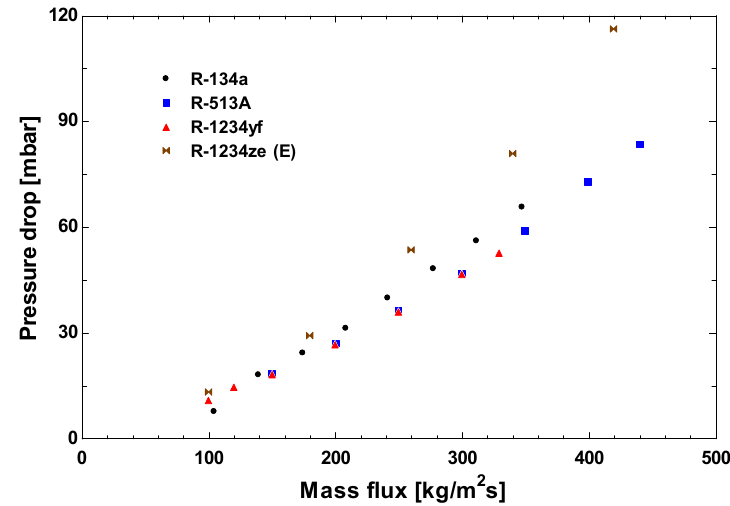
Figure 7. Refrigerant-side pressure drops with variation of the refrigerant mass flux.